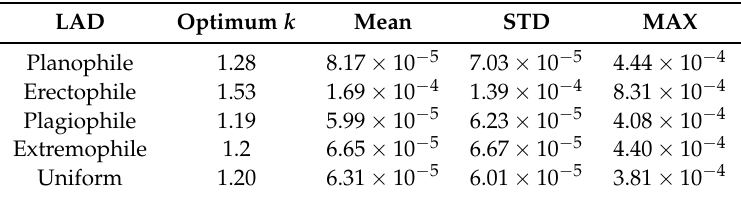
Table 5. Optimum k -value and statistical distributions of the errors in the adjusted asymmetric isoline equations, with the optimal k -values for each of the five LADs, including the planophile, erectophile, plagiophile, extremophile, and uniform distributions.